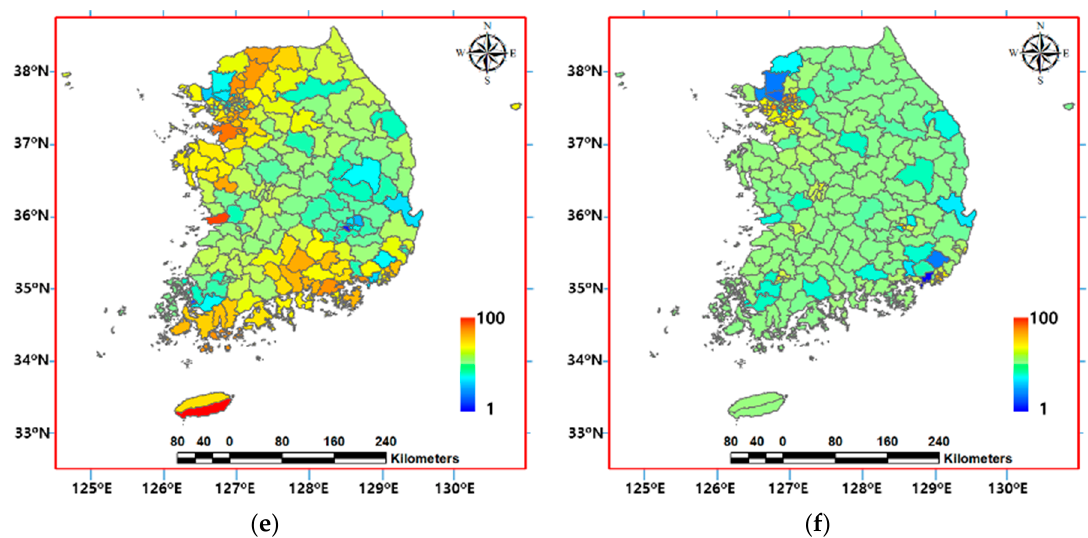
Figure 2. Spatial distribution of the primary and intermediate assessment components for the study site: ( a ) Exposure E ; ( b ) sensitivity S ; ( c ) lack of adaptability A ; ( d ) potential impact PI ; ( e ) livelihood vulnerability LV ; and ( f ) internal factor IF . Appl. Sci. 2019 , 9 , 2321